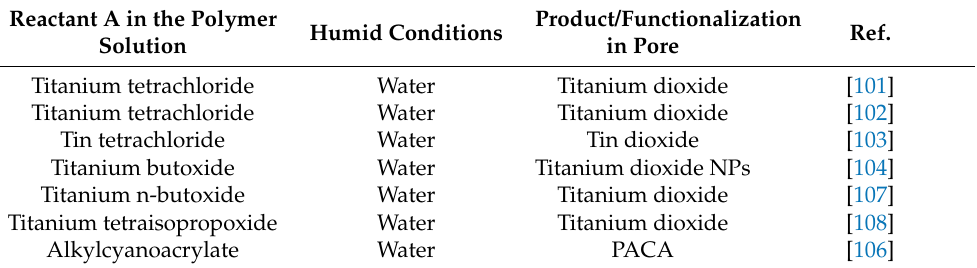
Figure 14. ( a ) Schematic representation showing different reaction conditions with the variance in time intervals of pouring (Ti(C 4 H 9 O) 4 ) solution to the PS solution. ( b – e ) shows the typical SEM images of PS film obtained at a different time interval. Reprinted with permission from ref. [104]. Copyright 2018 Polymer. Table 2. Summary of reports using one reactant in polymer solution and water from the humid atmosphere as another